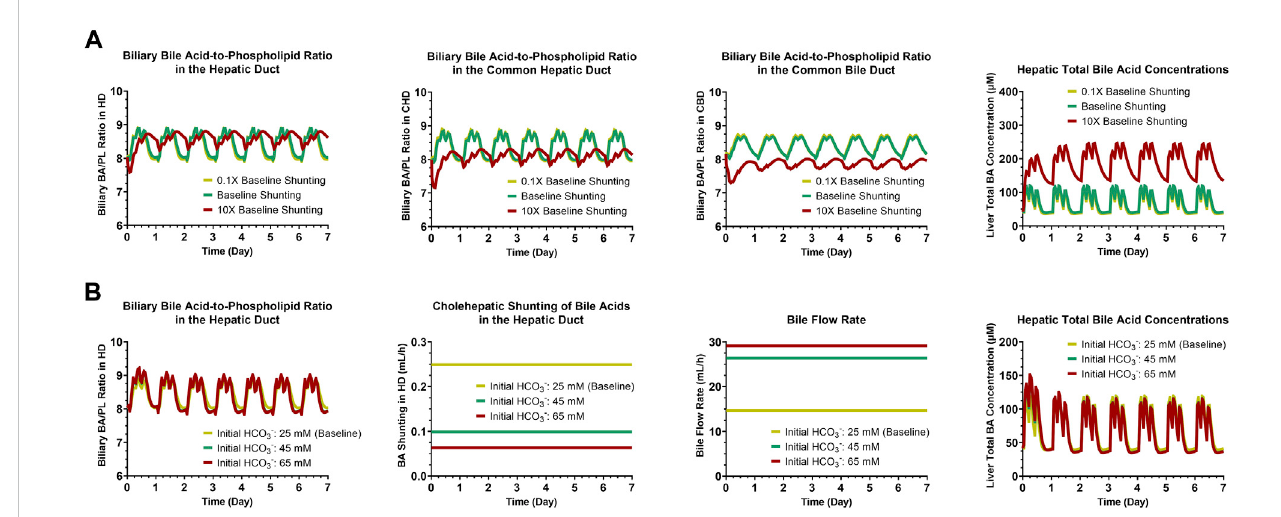
FIGURE 3 Simulation results for sensitivity analyses of cholehepatic BA shunting (A) and initial HCO 3 − concentrations (B) . BA, bile acid; CBD, common bile duct; CHD, common hepatic duct; HCO 3 − , bicarbonate; HD, hepatic duct; PL, phospholipid.